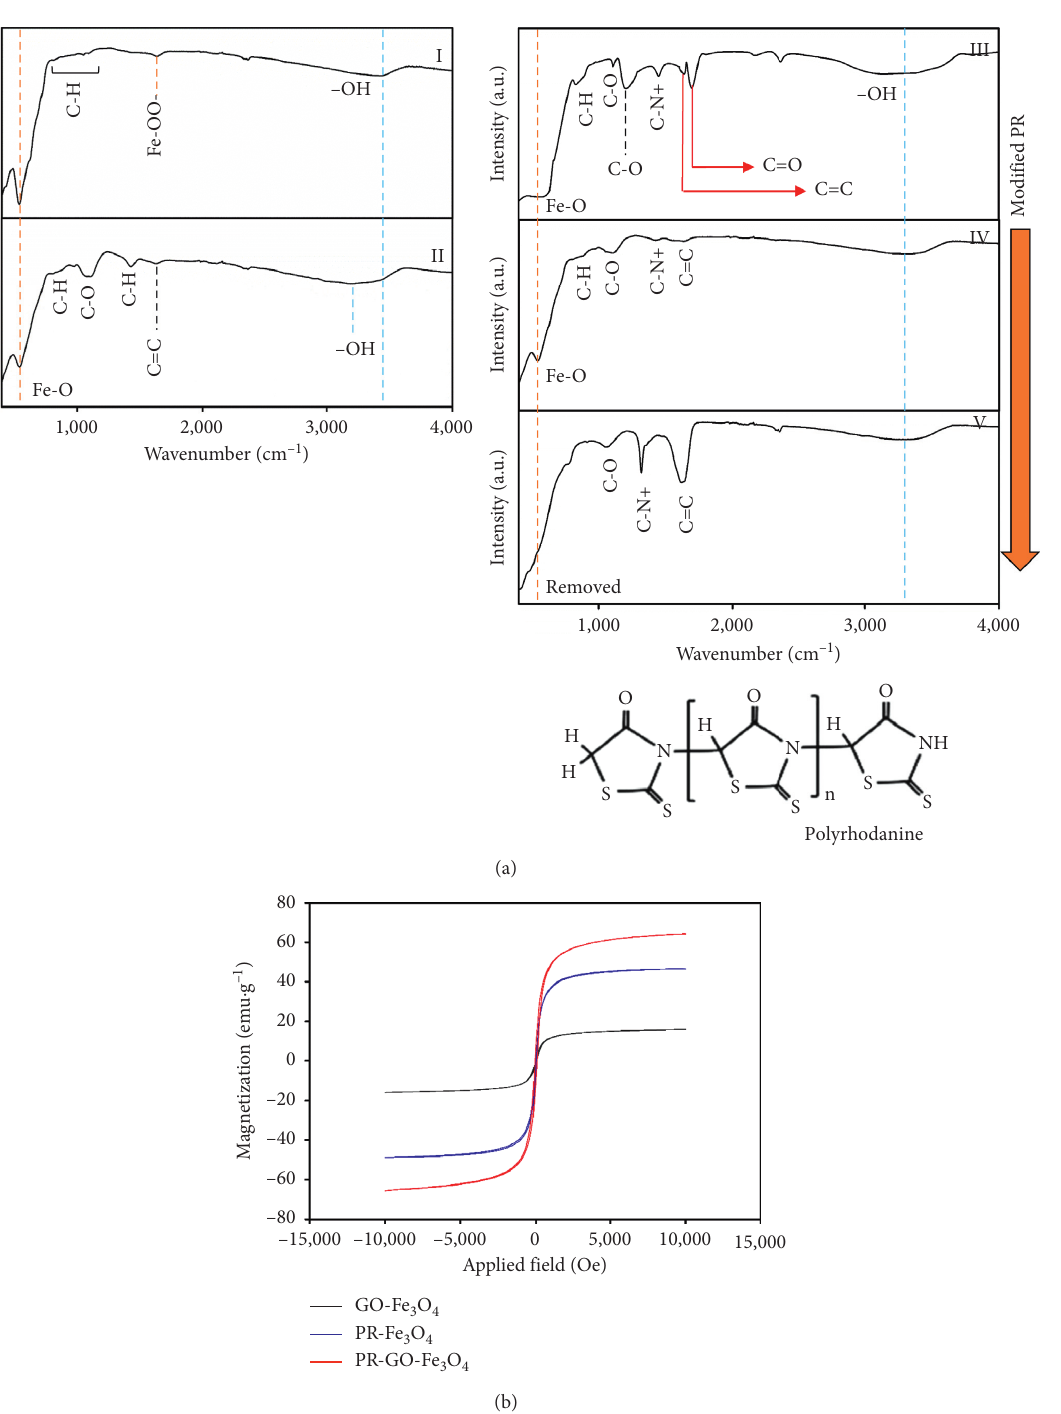
Figure 2: (a) FT-IR spectrums of (I) Fe 3 O 4 , (II) GO-Fe 3 O 4 , (III) PR-Fe 3 O 4 , (IV) PR-GO-Fe 3 O 4, and (V) modified PR-GO-Fe 3 O 4 with kombucha solvent; (b) VSM results of GO-Fe 3 O 4 , PR-Fe 3 O 4, and PR-GO-Fe 3 O 4